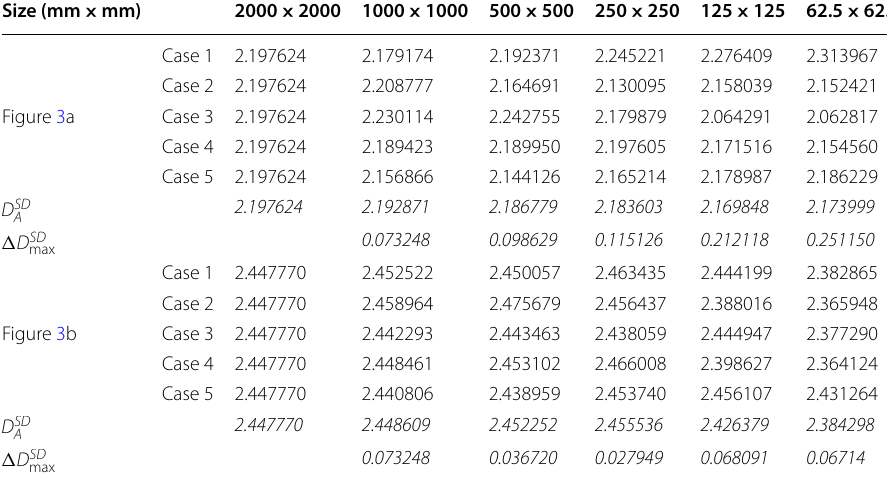
Table 5 Fractal dimensions for samples with different size at five